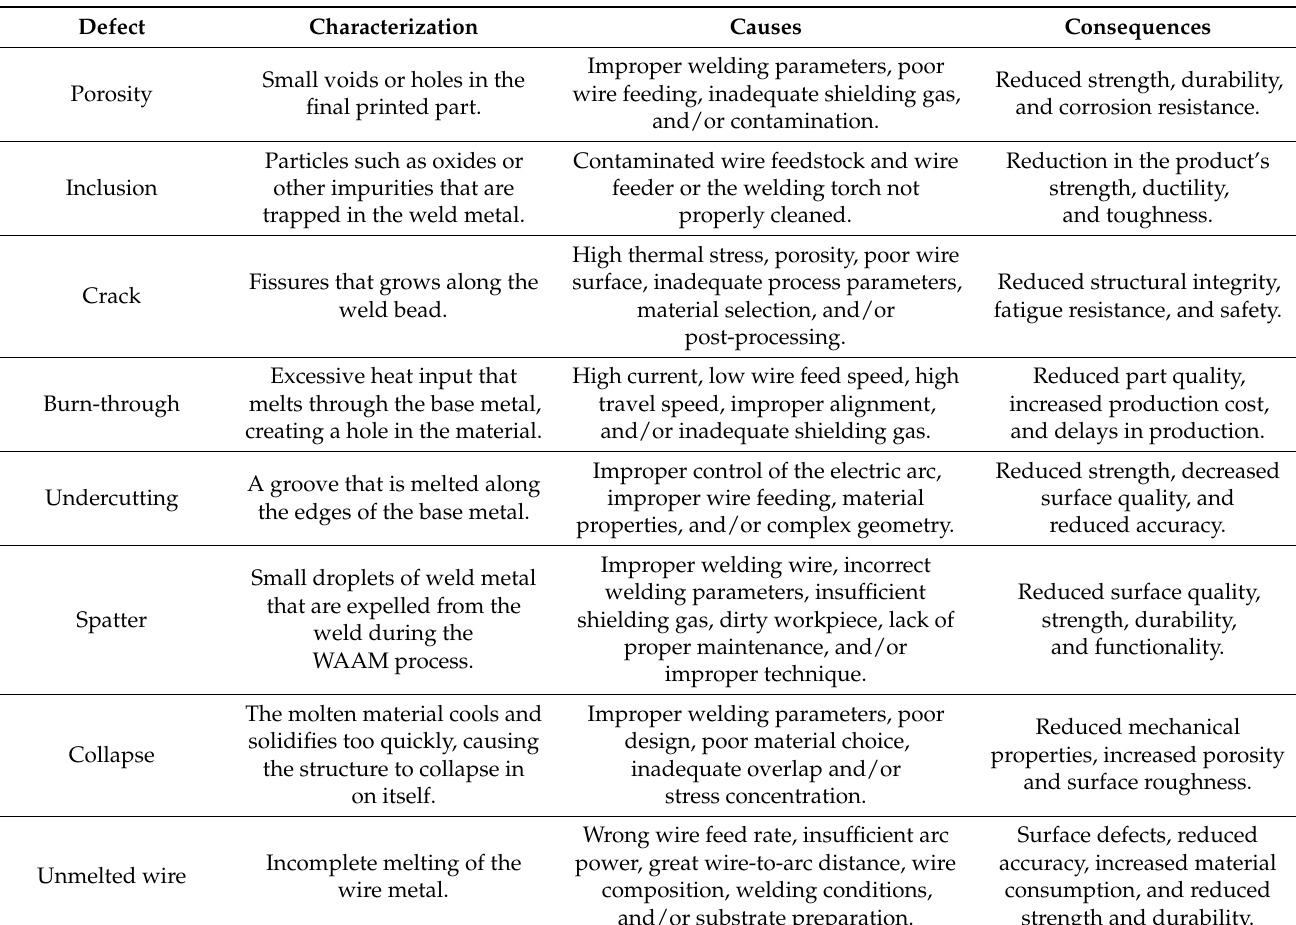
Table 1. Overview of the most common WAAM